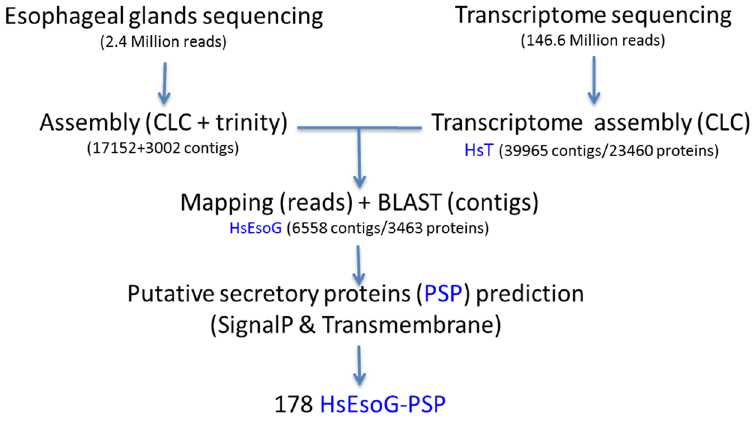
Figure 1. The pipeline to predict the H. schachtii esophageal gland related putative secretory proteins NEMBASE4 database (http://www.nematodes.org/nembase4) containing ESTs from 324 different cDNA librar- ies from 63 different nematode species 9 . Though ESTs sequencing can be used to predict putative effectors, this